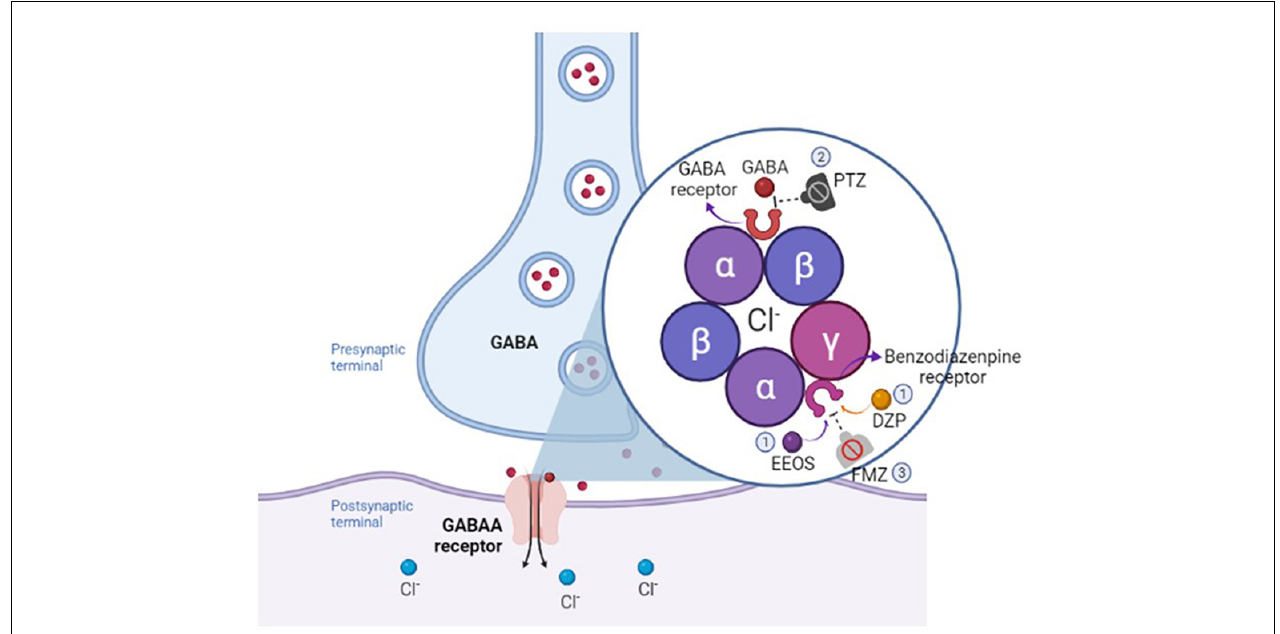
FIGURE 6 | Schematic illustration of the mechanism of extract of Euterpe oleracea stones (EEOS) or diazepam (DZP) on benzodiazepine (BDZ) receptor (1), followed by pentylenetetrazol (PTZ) antagonism on GABAA receptor (2), and flumazenil (FMZ), a competitive antagonist of the effect of benzodiazepine ligand (3).